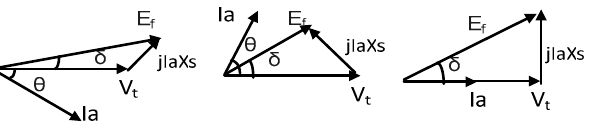
Figure 2. The phasor diagrams for the performance of PV buses with respect to different network-load demand-type resistances and capacitor reactance.